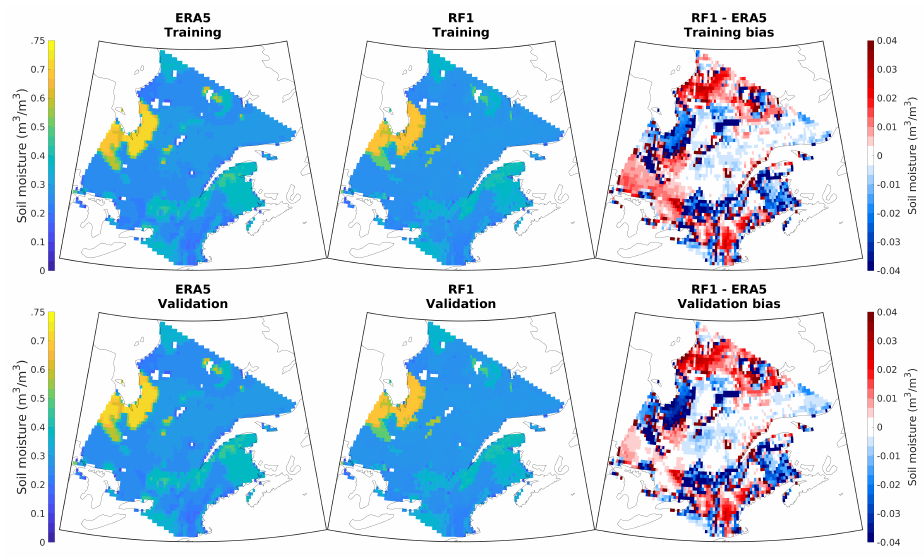
Figure 4. ERA5 ( left column) and RF1 simulated ( center column) SSM for training ( top panel) and validation ( bottom panel) periods and their biases ( right